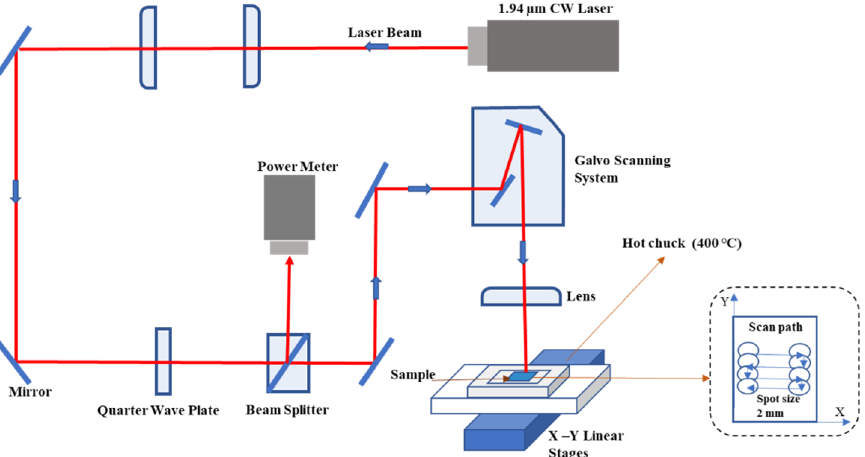
Figure 1. Schematic of the experimental setup for the CW laser annealing with a beam scanning system.